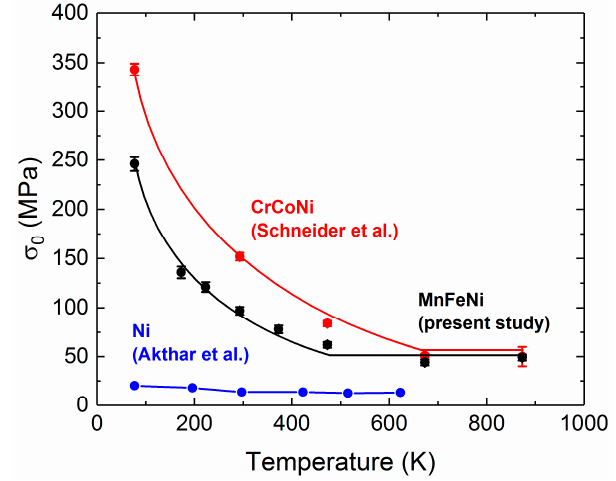
Figure 12. Yield strength ( σ 0 ) of single crystalline Ni [50] and polycrystalline CrCoNi [21] and MnFeNi (present study) extrapolated to an infinite grain size represented in blue, red and black, respectively, as a function of temperature determined by extrapolation of the grain sizes.